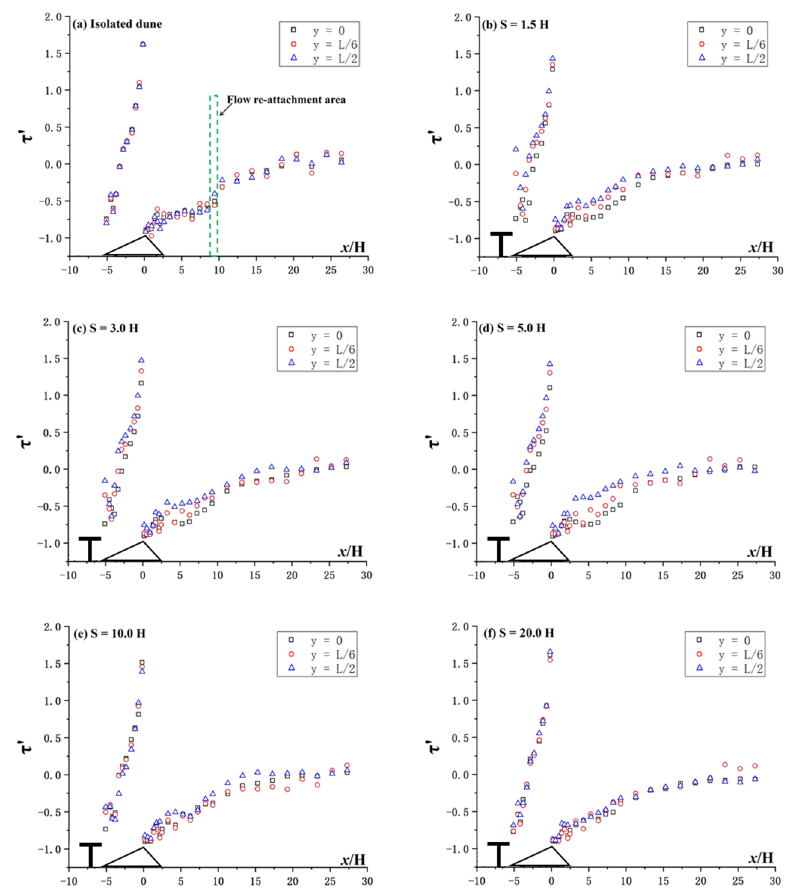
Figure 5. Normalized value of shear stress τ (cid:48) with normalized distance x / H. H is the height of sand dune, L is the distance of piers of bridge, S is the distance between bridge and sand dune and y is the distance between measuring position and the y-axis.